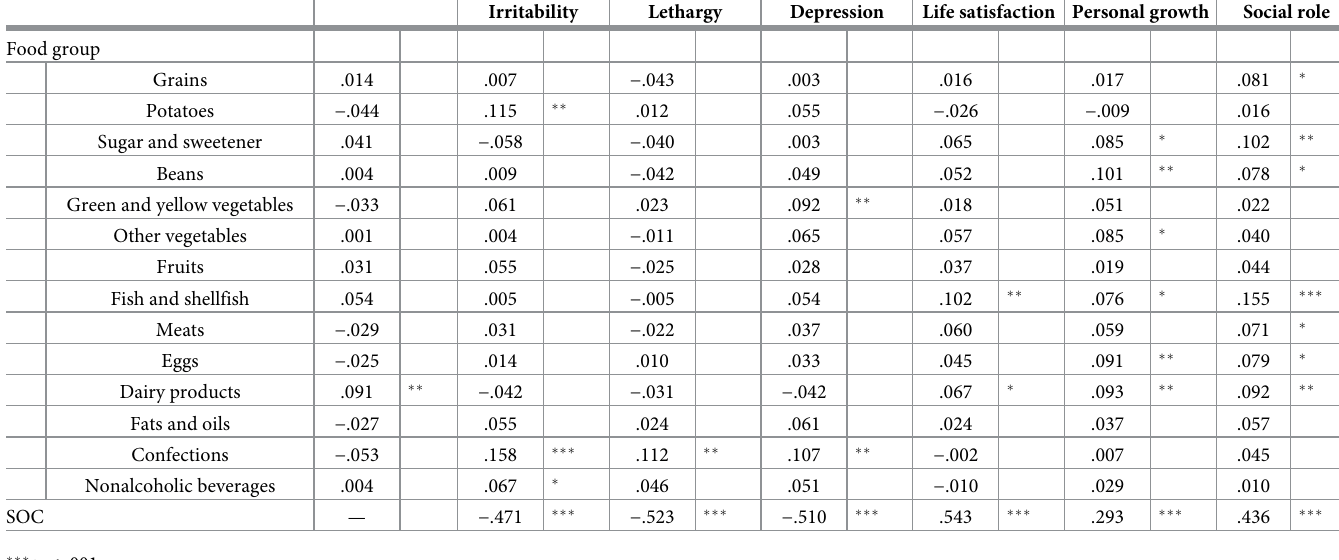
Table 3. Correlations among food group intake and SOC, stress response, and well-being. Irritability Lethargy Depression Life satisfaction Personal growth Social